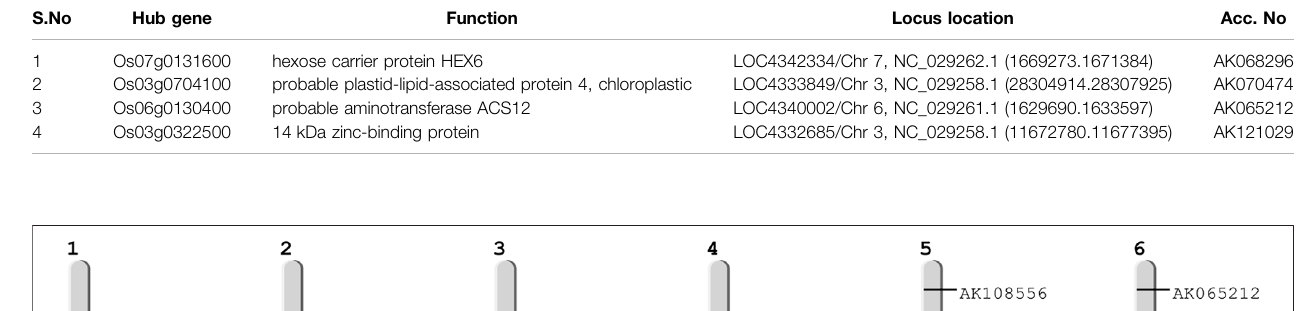
TABLE 9 | Identi fi ed hub genes with respect to their level of connectivity in the grey module. S.No